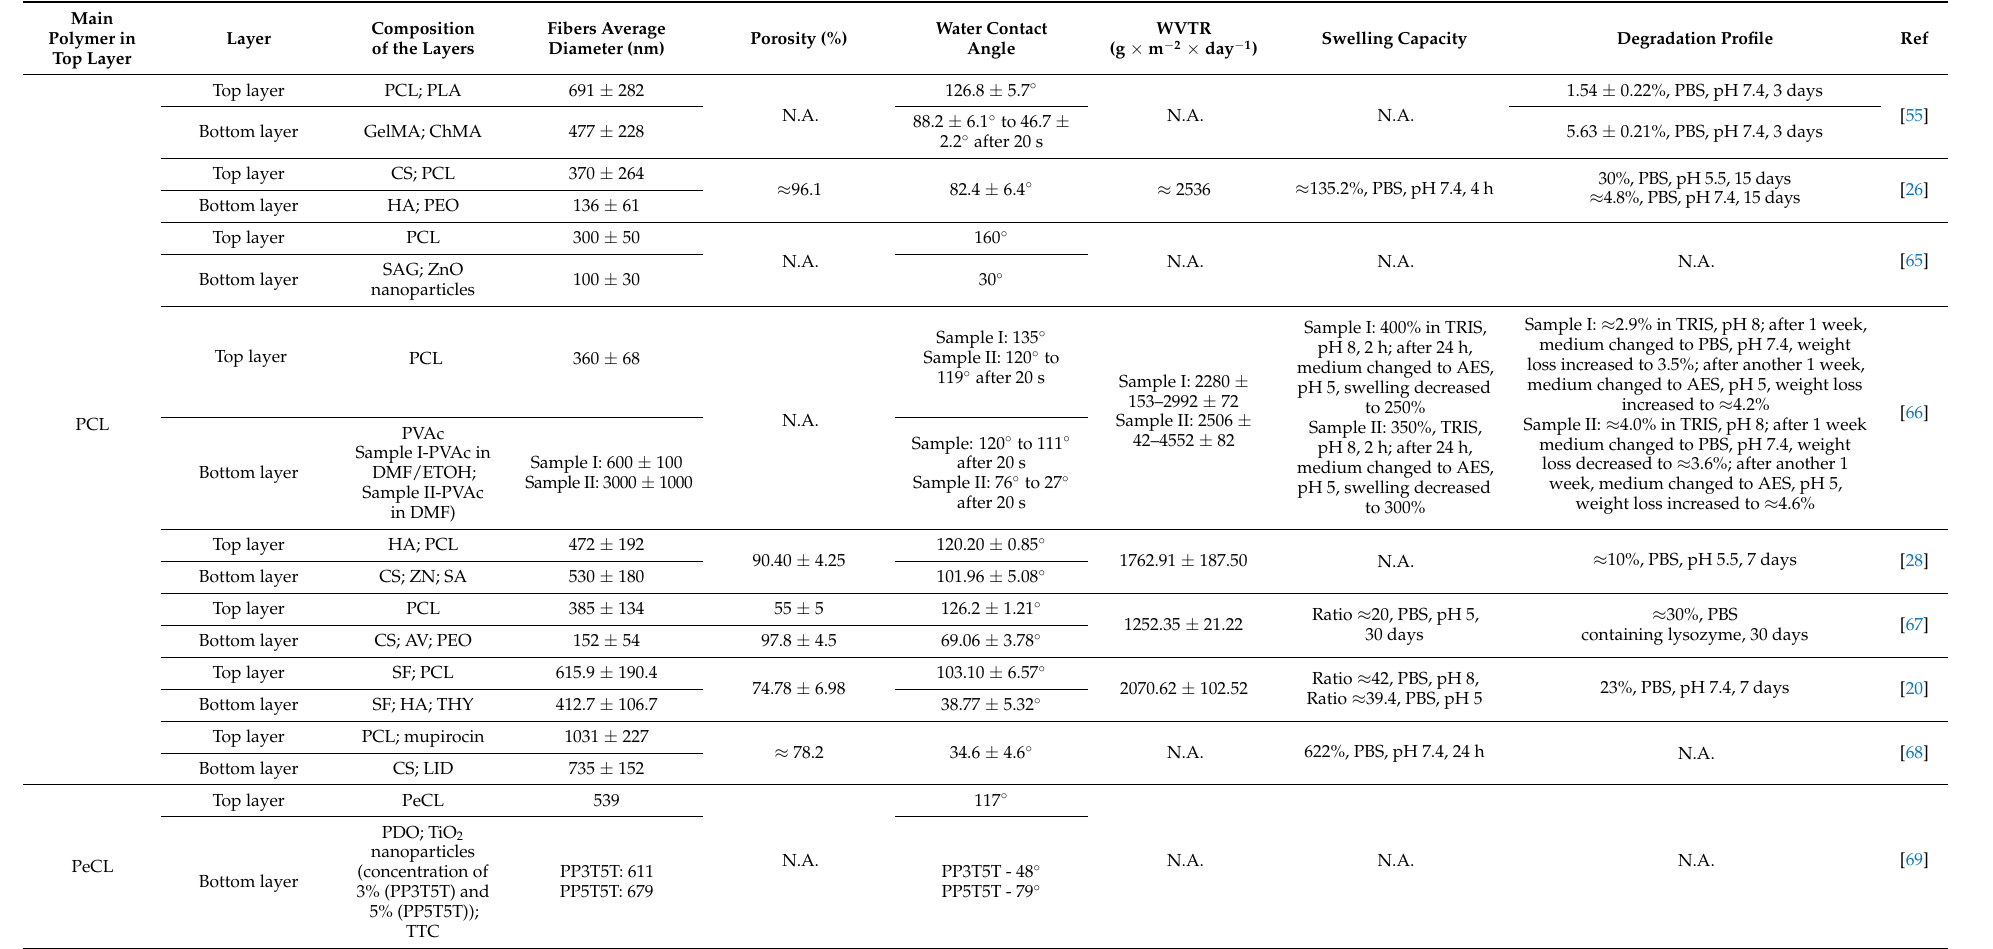
Table 1. Asymmetric membranes produced through electrospinning aimed to be used as wound dressings. Note: The merged cells report the values obtained for the asymmetric electrospun